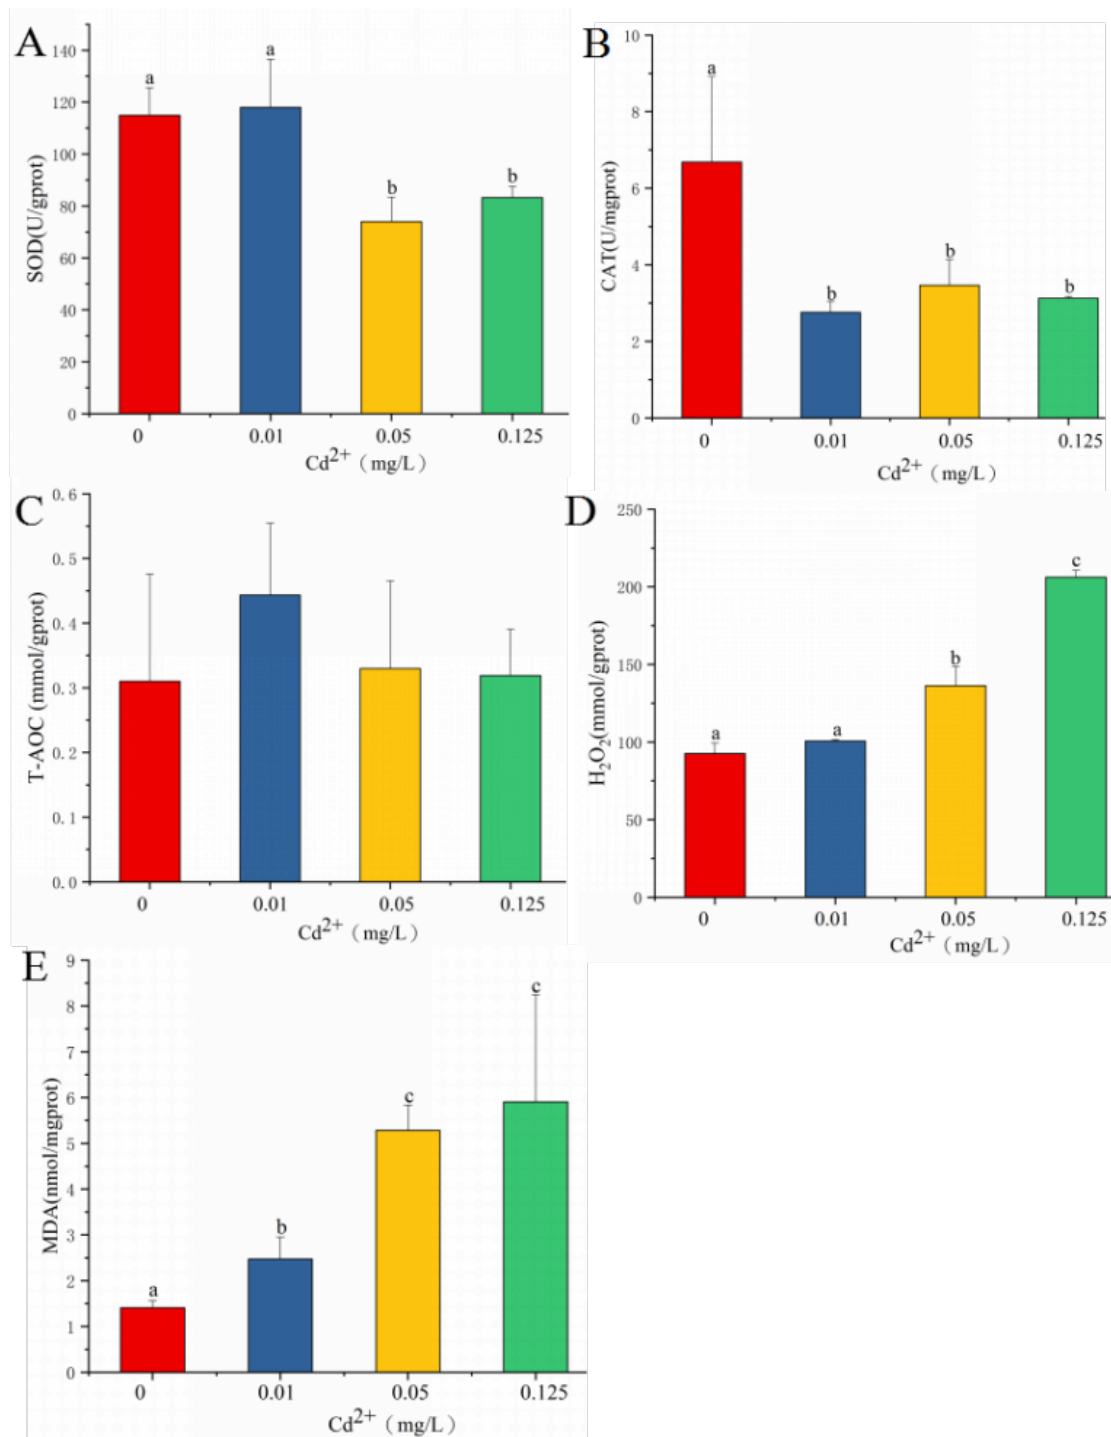
Figure 1. SOD ( A ), CAT ( B ), T-AOC ( C ), H 2 O 2 ( D ), and MDA ( E ) after cadmium exposure. Values are expressed as the mean ± SD. Different letters reflect significant differences between the control group and the cadmium treatment groups ( p < 0.05).